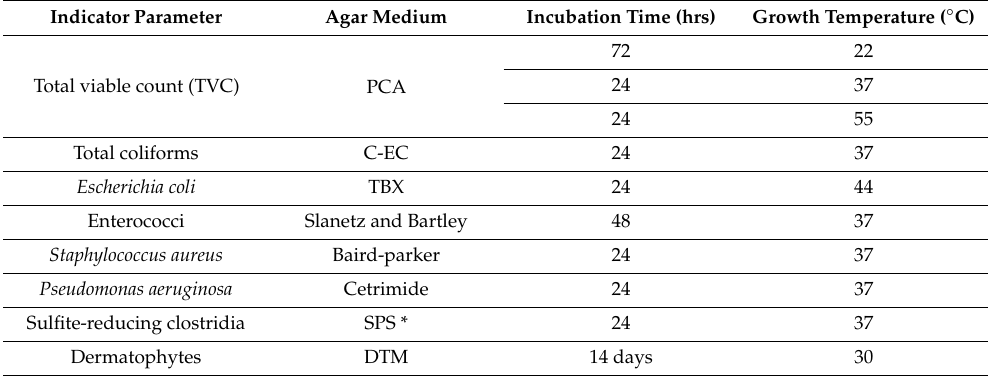
Table 1. Microbiological quality indicator parameters. Agar media and growth conditions, i.e., incubation time and temperature, are hereby reported. PCA—Plate Count Agar; C-EC—Chromogenic Coliform agar; TBX—Tryptone Bile X-GLUC agar; SPS—Sulphite Polymyxin Sulphadiazine; DTM—Dermatophyte agar. * SPS agar plates were incubated in anaerobic conditions, within an anaerobic jar (AnaeroJar 2.5 L, Oxoid Ltd., Basingstoke,